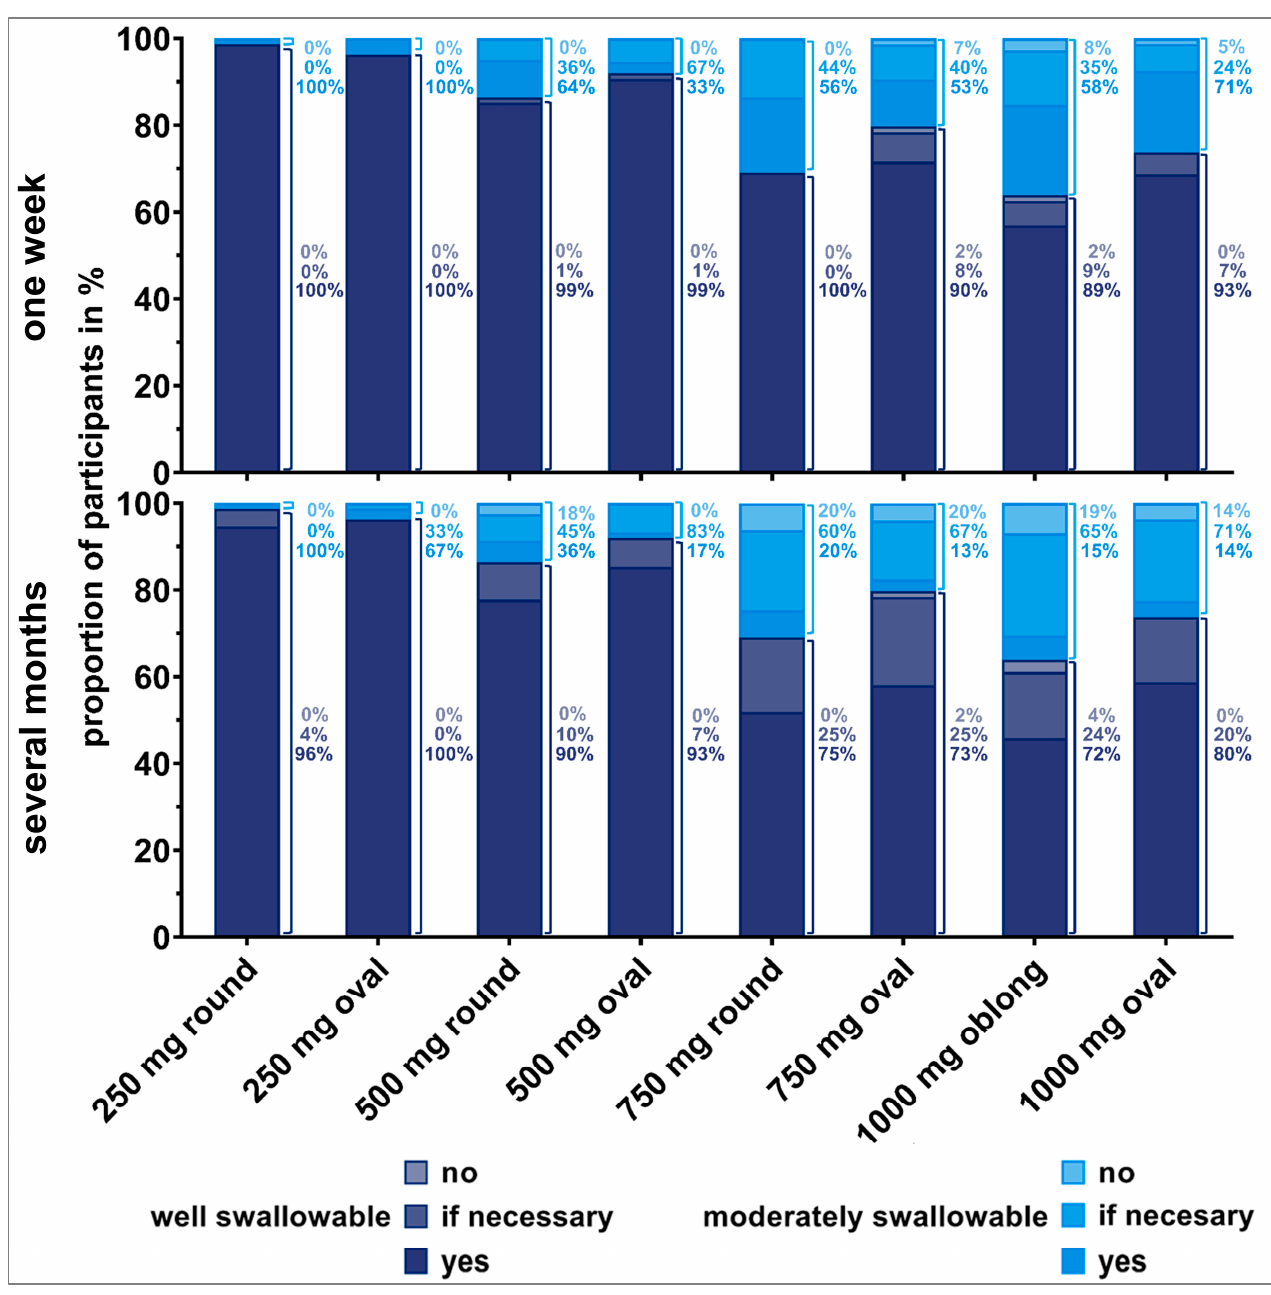
Figure 6. Willingness ( no , if necessary , yes ) of young participants to swallow the respective tablet once a day for one week (upper panel) or over several months (lower panel) dependent on tablet’s swallowability rating. Only the answers from participants who were able to swallow the tablets were considered here (corresponding to 100% value). Thus, zero to three evaluations from each participant are included. Percentages to the right of the bars are representing the fractions of the di ff erent willingness levels, if all deglutition a tt empts of each swallowability rating ( well or moderately swallowable ) are set to 100%.